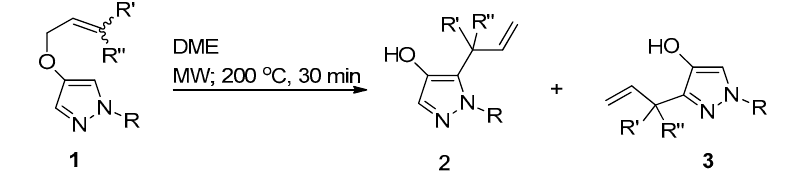
Table 1. Regioselectivity of Claisen rearrangement of 1 .